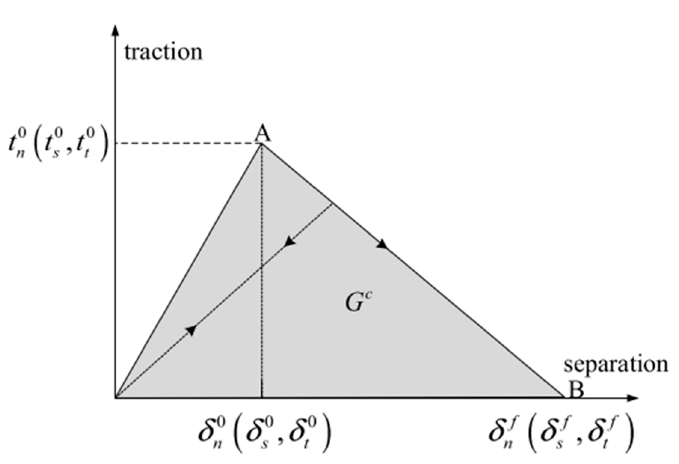
Figure 34. Typical traction–separation response. Reproduced with Creative Common License [249].